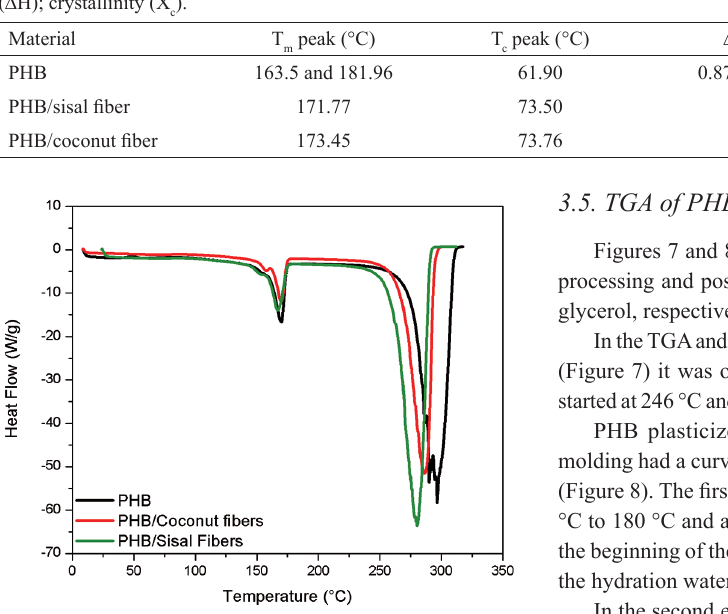
peak); variation melting enthalpy m